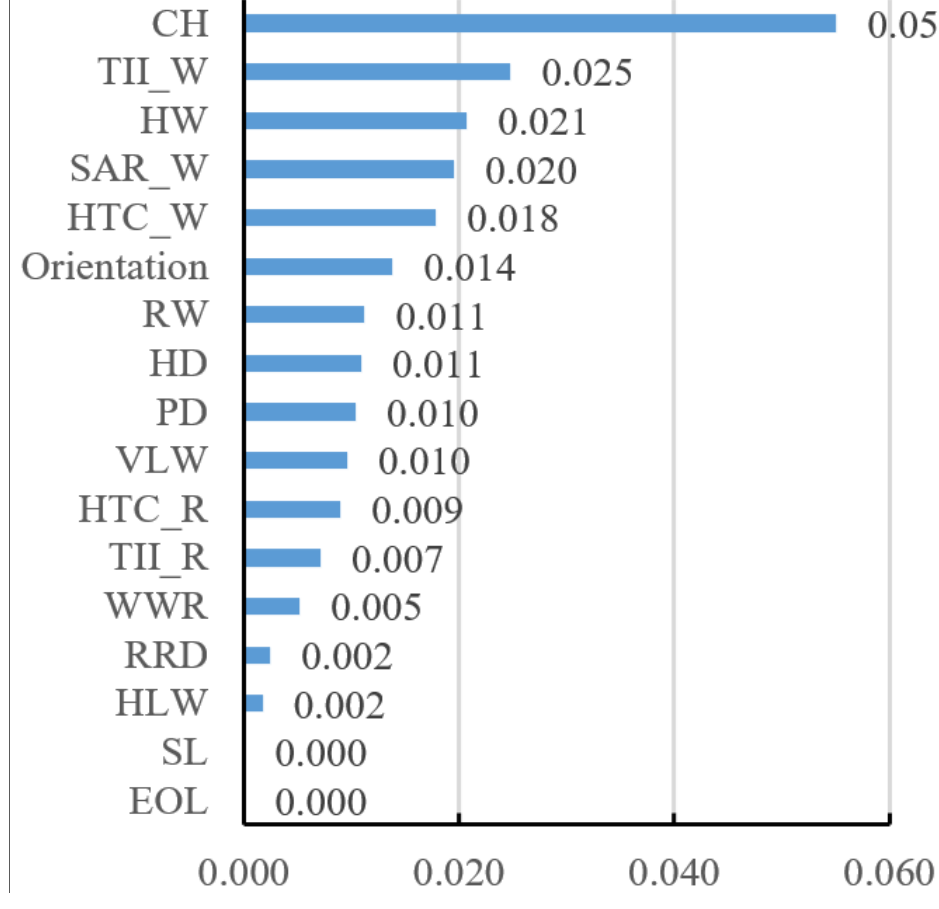
Figure. 13 The sensitivity coefficients of design factors for Xiashanhu houses